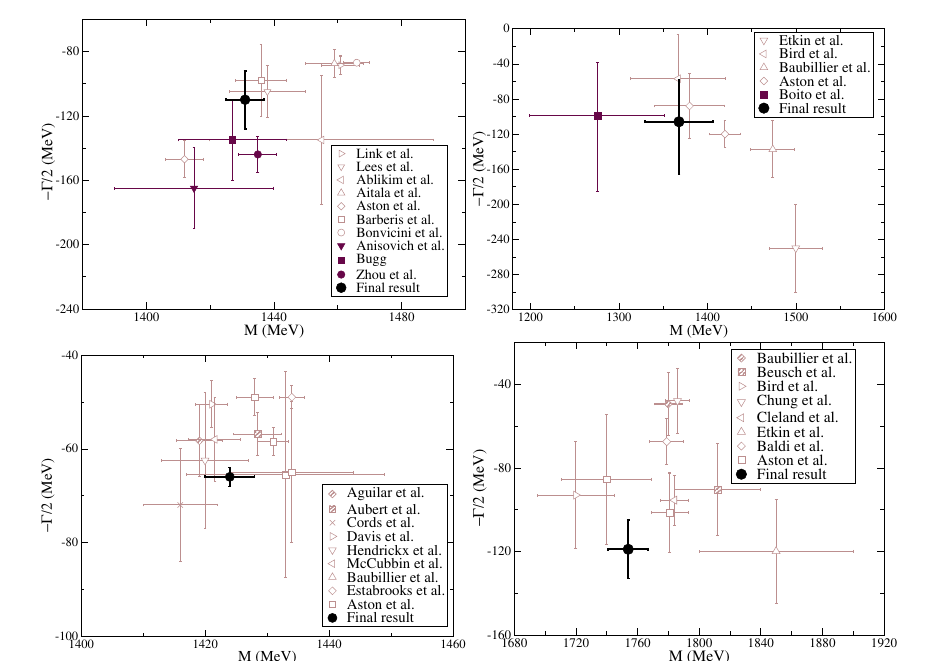
Figure 1. Pole positions of the K ∗ K ∗ (1780) (bottom-right) extracted from data fits constrained with Forward Dispersion Relations and 3 using sequences of Padé approximants for the analytic continuation to the complex plane. Also